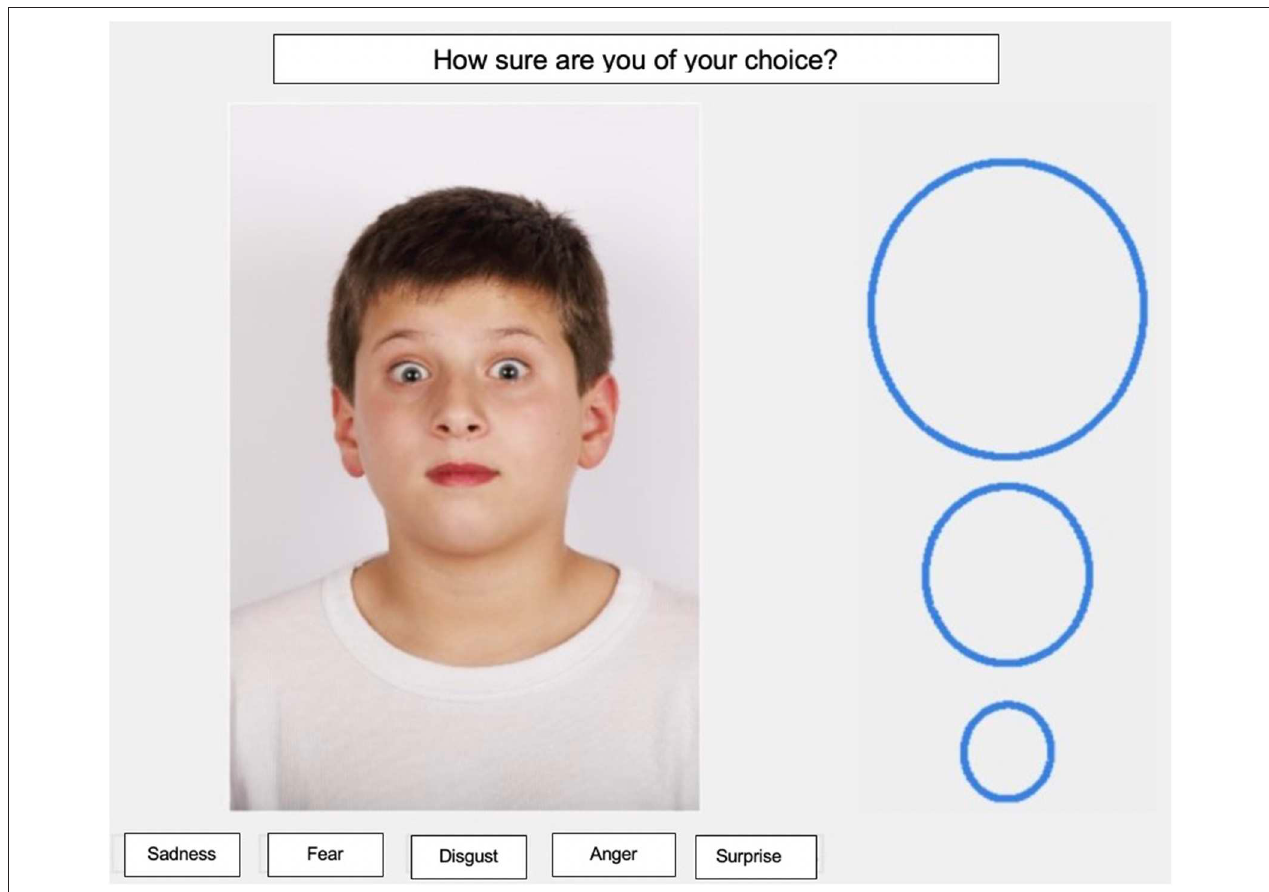
FIGURE 2 | Reactive in which the subject is consulte regarding the level of confidence with which he issues his